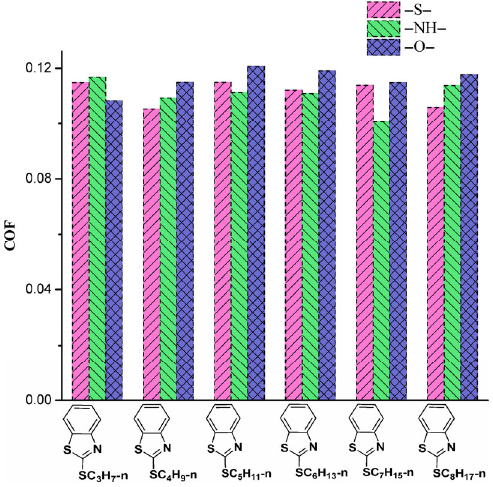
Fig. 19 The friction coefficient when lubricating with thioben- zothiazole compounds and their isosteres in